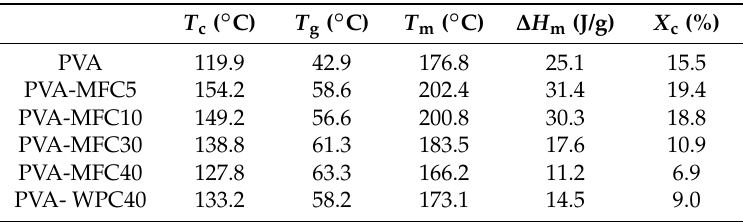
Table 1. Thermal data of PVA-based